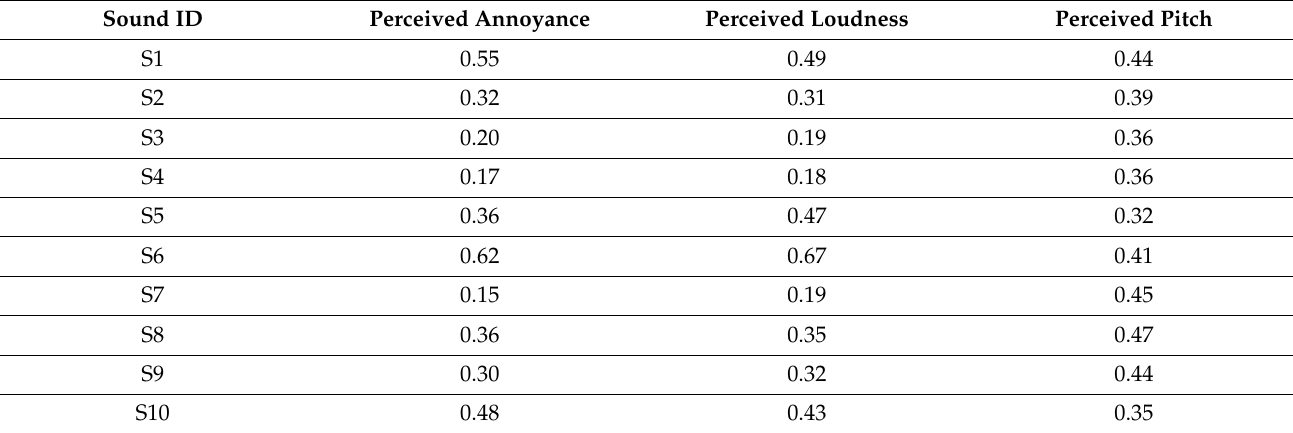
Table 3. Coefficient of variation for each test sound and for perceived annoyance, loudness and pitch. Sound ID Perceived